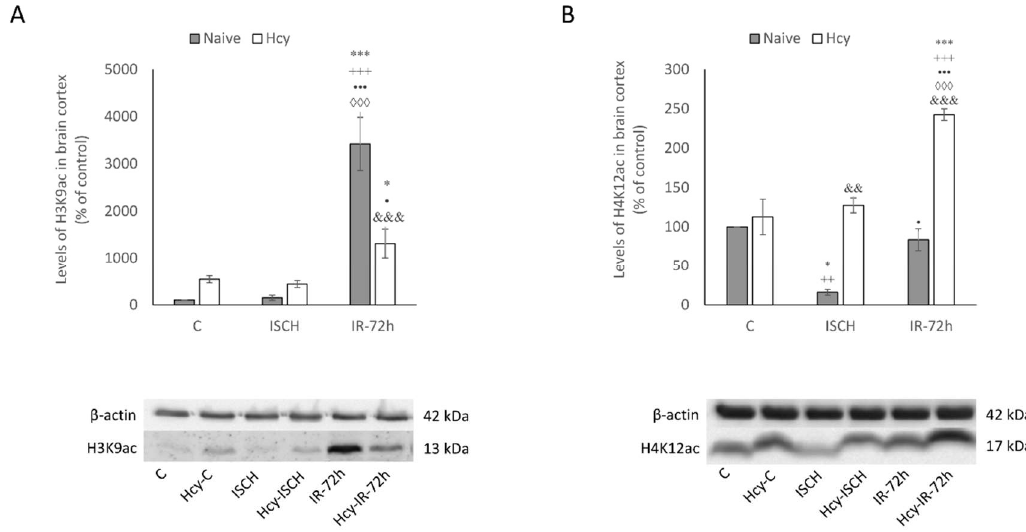
Figure 4. Western blot analysis of H3K9ac ( A ) and H4K12ac ( B ) levels in rat brain cortex homogenates. Levels of histones acetylation in the M1 area in naive control, Hcy-C, naive ISCH, Hcy-ISCH, naive IR-72h and Hcy-IR-72h. Results are presented as mean ± SEM, n = 5/group, normalized to the control levels. * p < 0.05 and *** p < 0.001 versus the control value; ++ p < 0.01 and +++ p < 0.001 versus the control